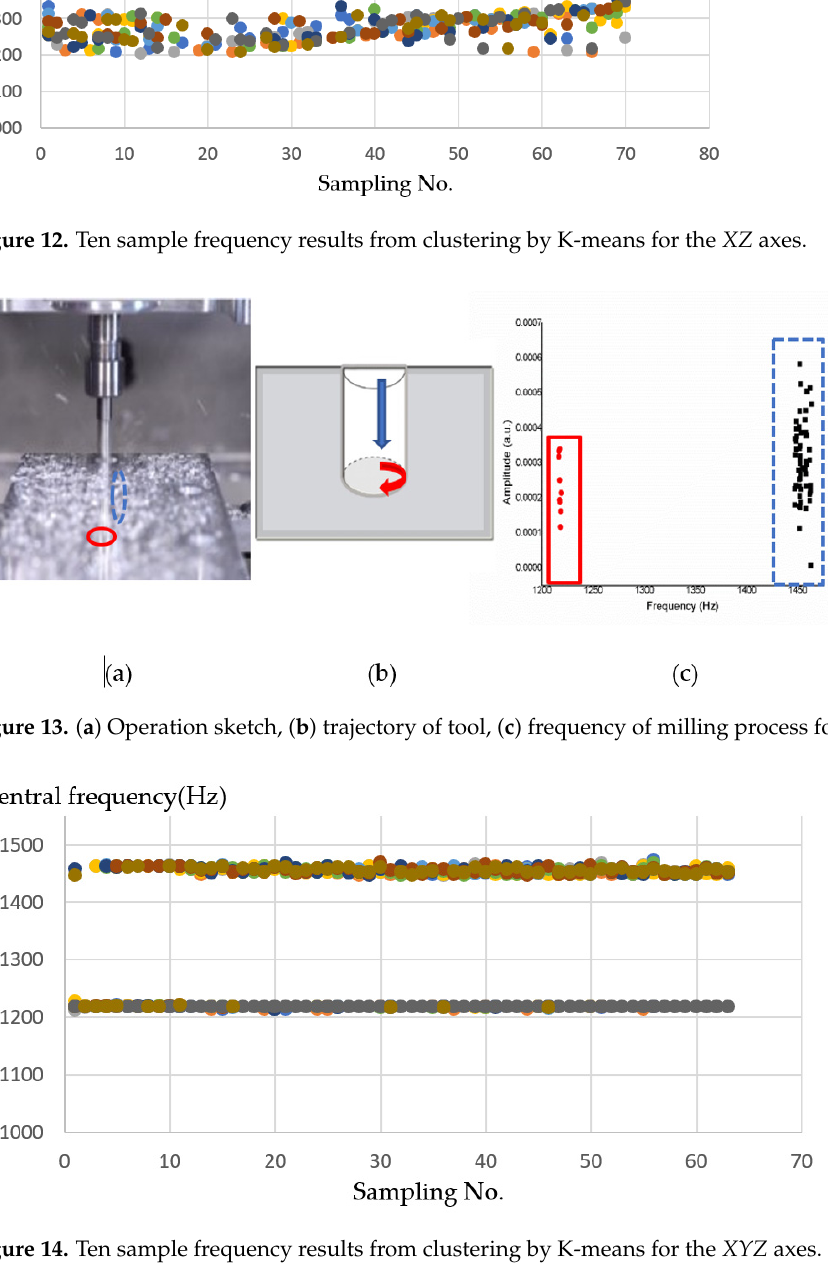
Figure 14. Ten sample frequency results from clustering by K-means for the XYZ axes.